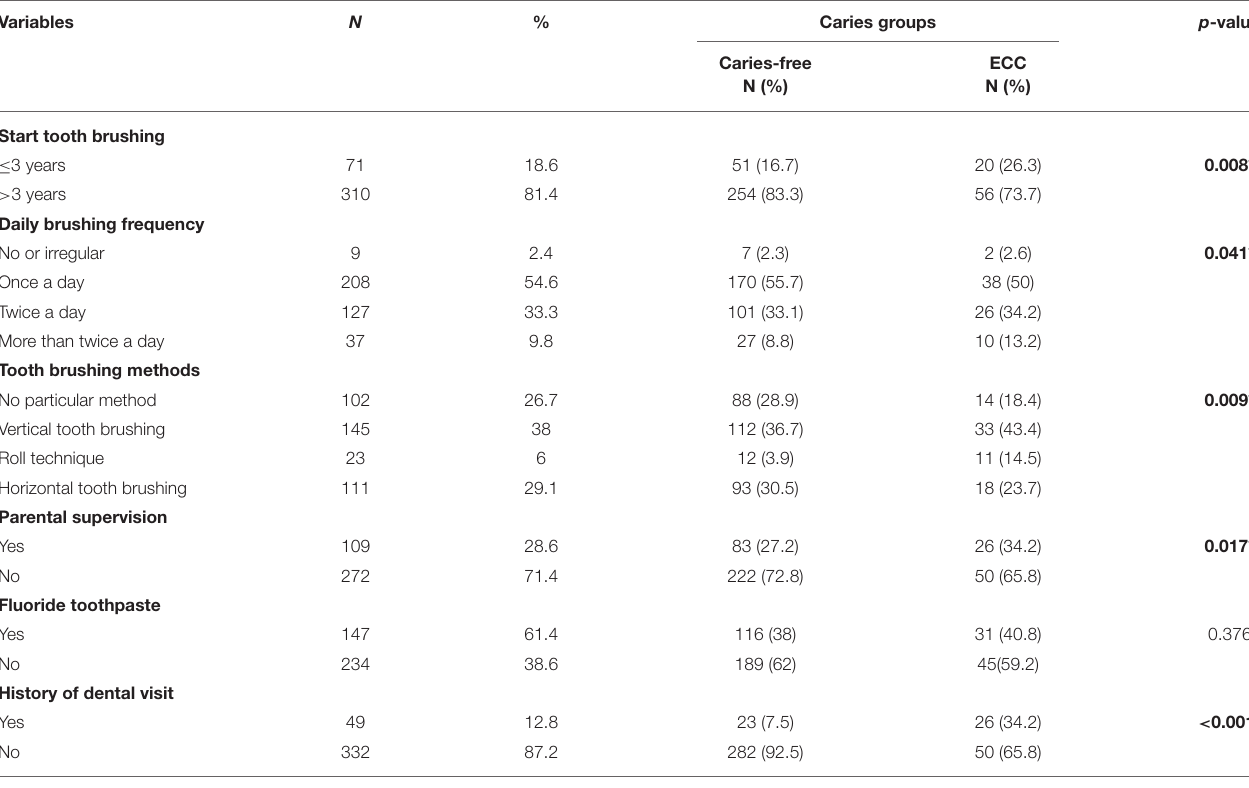
TABLE 3 | Prevalence of ECC and oral hygiene behaviors/dental history ( N = 381). Variables N % Caries groups p -value